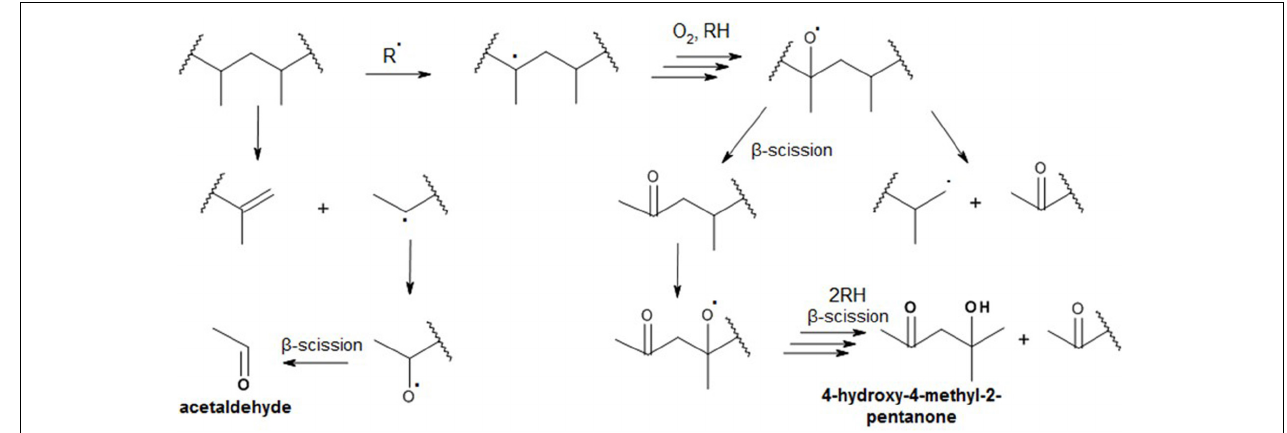
FIGURE 2 | PP degradation global scheme [Badji, 2017; from Bernstein et al.